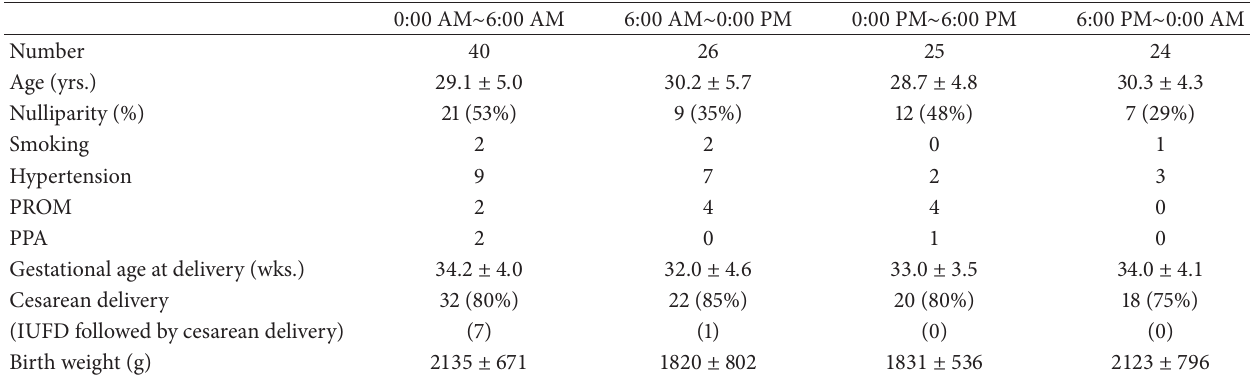
Table 2: Demographic data of each group for the four 6-hour intervals in regard to placental